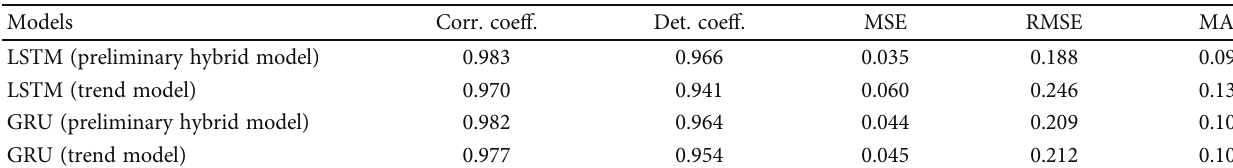
Table 1: Preliminary model comparison.